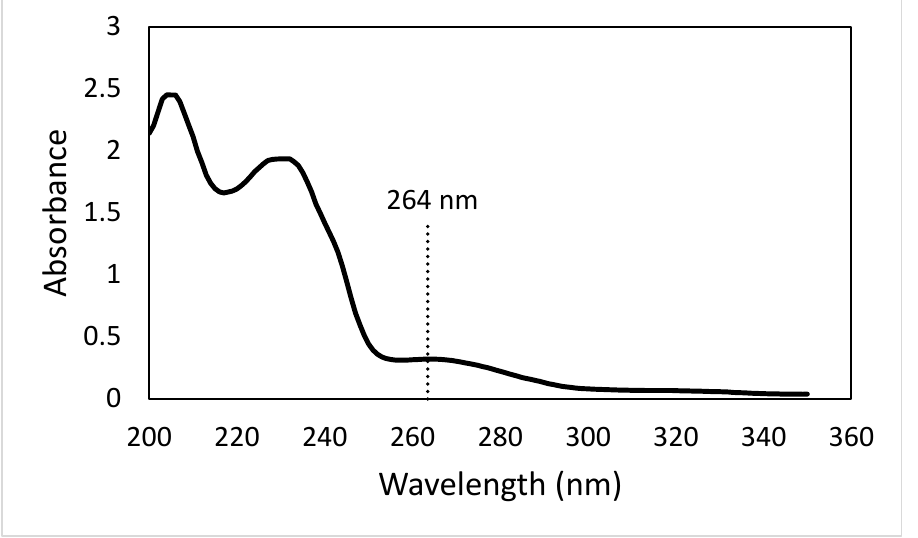
Figure 7. Average absorbance spectrum in the 200–350 nm region for the leaflet washes obtained from the BC5F1 generation. The vertical dashed line identifies 264 nm, the λ max for isolated 7-epi zingiberene.